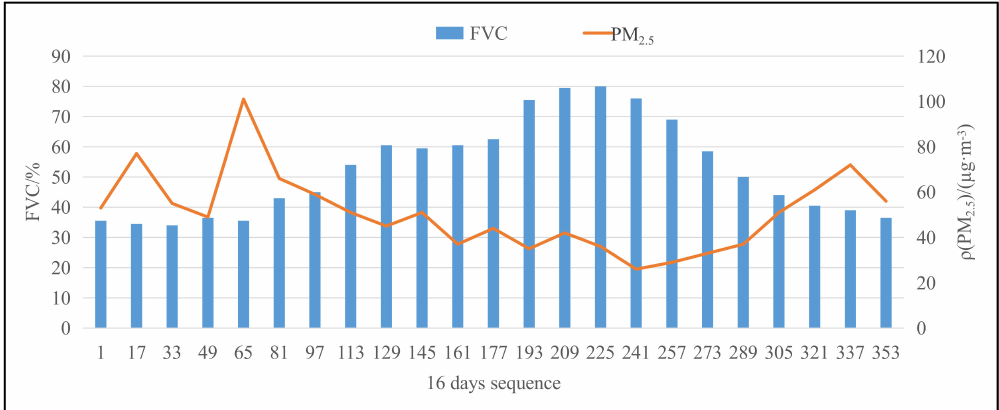
Figure 11. Average 2018–2019 fractional vegetation cover (FVC) and PM 2.5 mass concentration for each 16-day sequence across the Beijing-Tianjin-Hebei